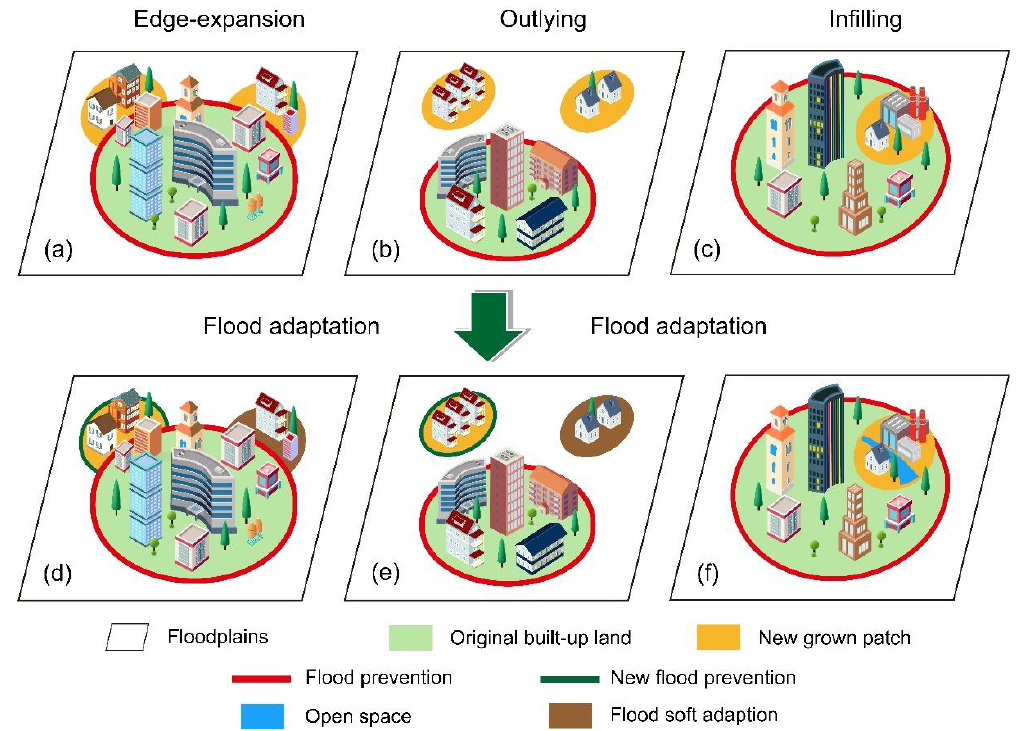
Figure 15. The impact of different expansion types on the flood vulnerability of BLF patches and the adaptation measures. ( a – c ) represent the current flood prevention in the edge-expansion, outlying, and infilling patches, respectively. ( d – f ) indicates flood adaptation measures for the three expansion types of BLF patches.